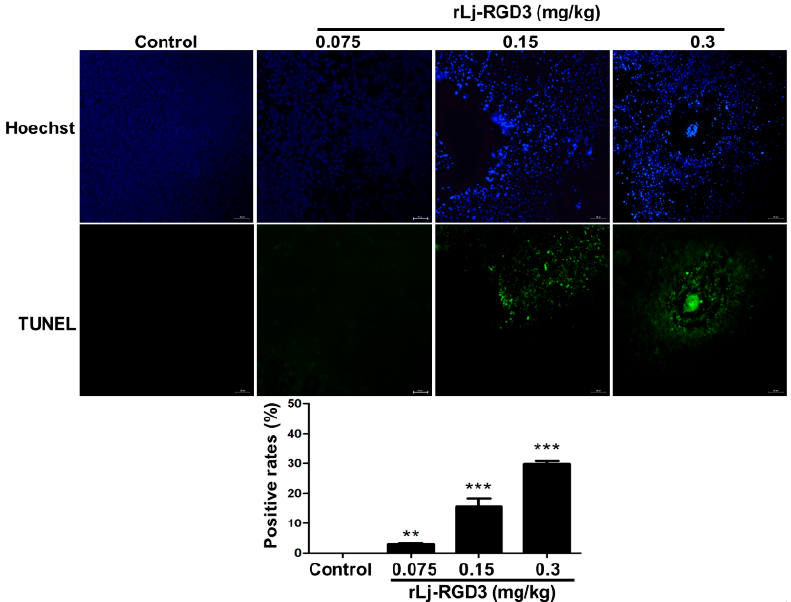
Figure 6. rLj-RGD3 induced apoptosis (200×) in the tumors of the HeyA8 xenografted mice. The nuclei (blue signals) of the HeyA8 cells in the solid tumor tissues are shown in the first line. The green signals which indicated the apoptotic cells in the TUNEL assay are shown in the second line. The positive rates of the apoptotic cells were shown in a histogram. Relative to the control group: ** p < 0.01; *** p < 0.001.